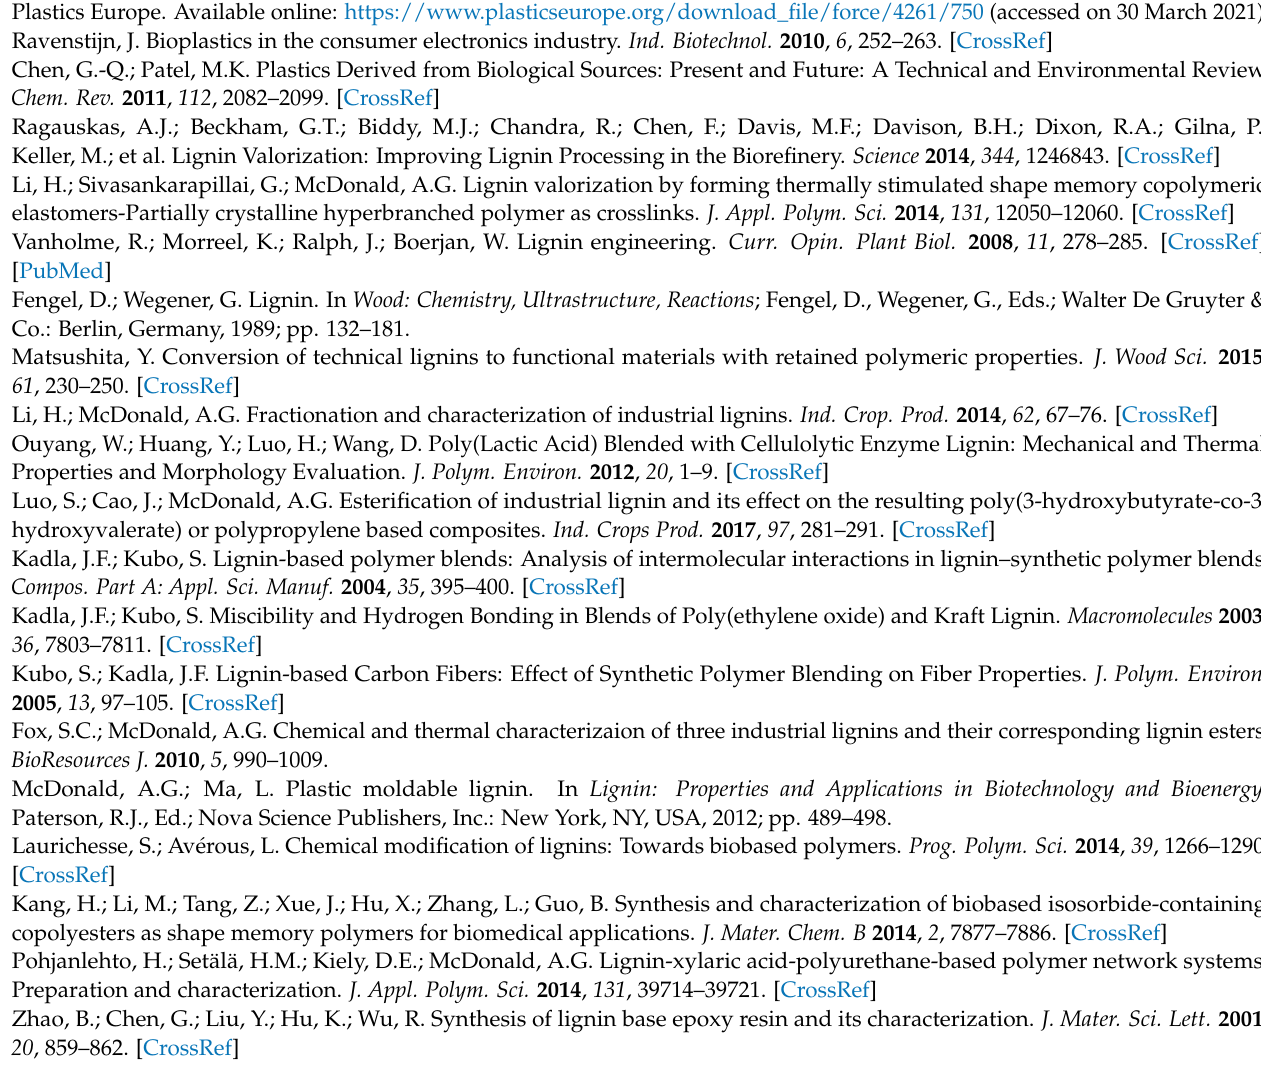
Figure S10: DSC thermograms (1st heat cycle, endotherm down) of BSu1-0–50%lignin copolymers (top) and showing 1st and 2nd heat cycles of BSu1-0–30%lignin copolymers